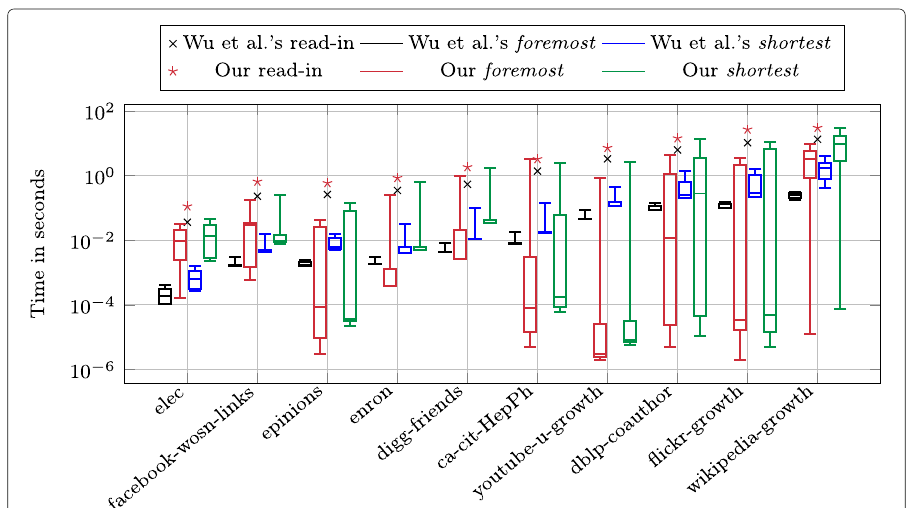
Fig. 3 Running time comparison for computing foremost and shortest walks. For each graph there are four box plots. From left to right these correspond to the following algorithms: foremost of Wu et al. (black), our foremost (red), shortest of Wu et al. (blue), our shortest (green). The boxes represent the 25% to 75% percentile of running times over the 100 runs for different sources on the respective temporal graph and the line within the boxes illustrates the 50% percentile (the median). The whiskers on the top and the bottom represent the best and worst running times, respectively. We only depict the running times of the algorithms after the data has been read in and was preprocessed by Transformation 1. The two plots with the crosses show the running times of reading in the input and preprocessing